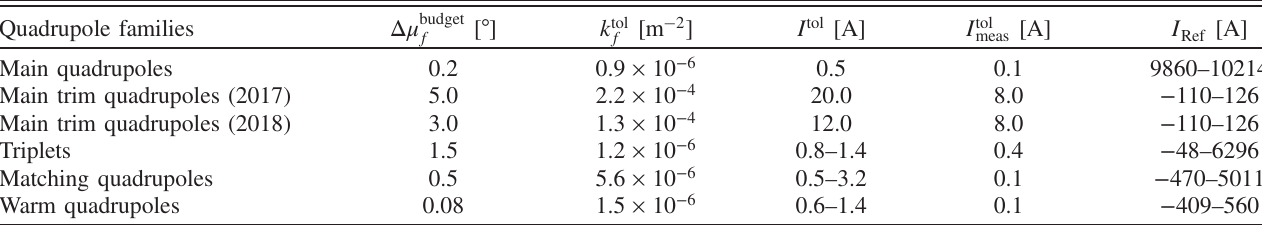
TABLE IV. PcInterlock tolerances, k tol f and I tol , on quadrupole strength and currents operationally used in 2017 = 18 with β (cid:1) ¼ 30 cm. The only difference between the years is the reduced phase budget of the trim quadrupoles, giving Δ μ budget ¼ 5 . 2 ° in 2017 and Δ μ budget ¼ 3 . 4 ° in